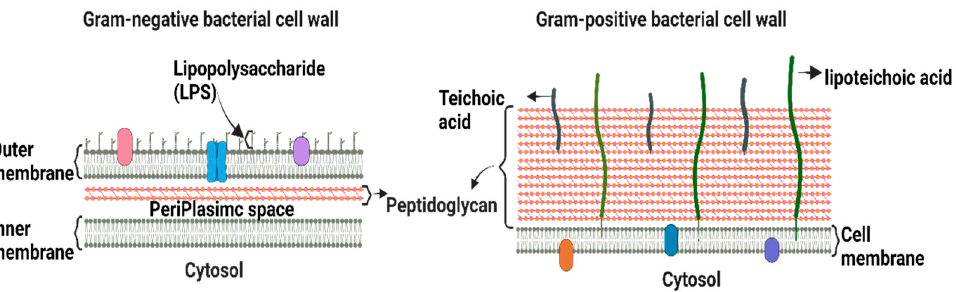
Figure 1. Schematic depiction of the key structural differences between Gram-positive and Gram- negative bacteria.